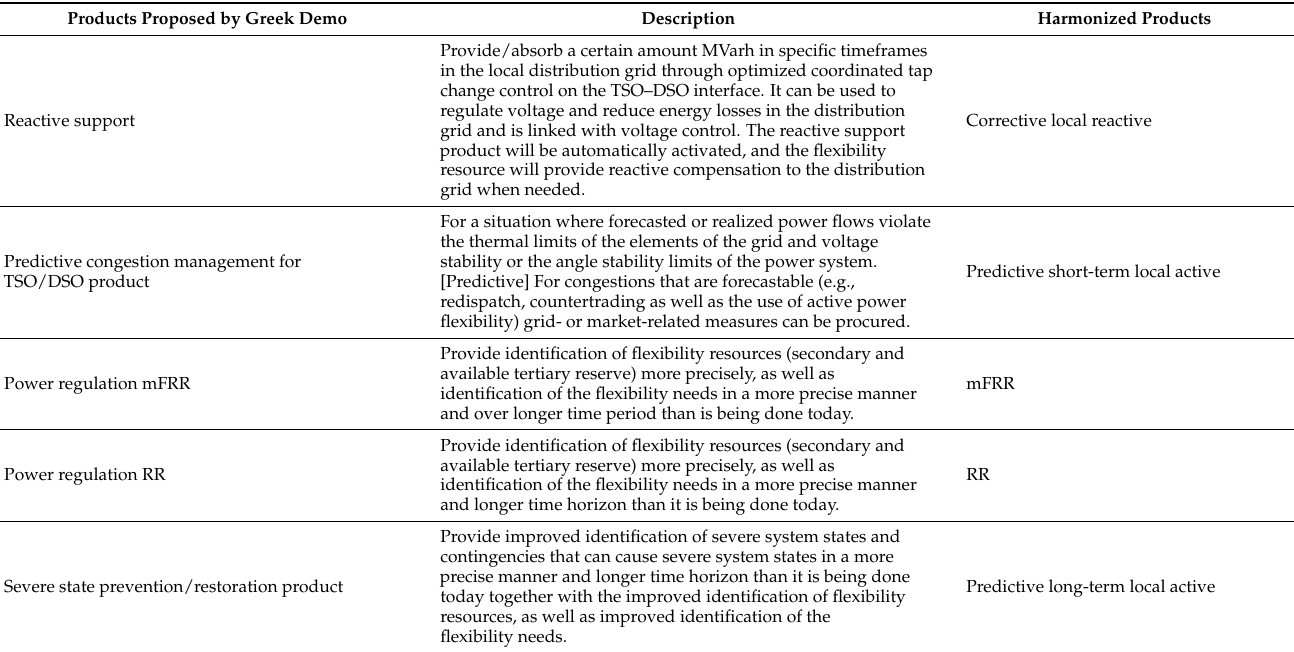
Table 10. Harmonization of the products identified by the Greek